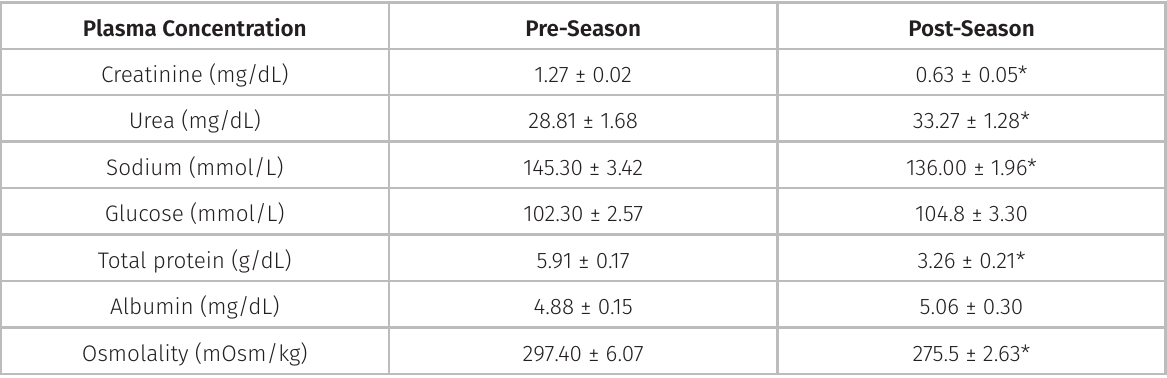
Table I. Plasma solute concentration (Mean ±